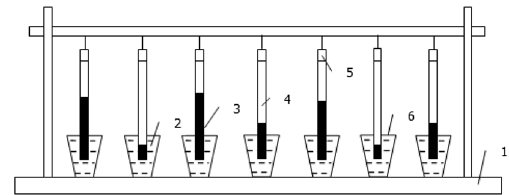
Fig. 1 Flowchart of self-priming speed method. 1 Bracket, 2 wetting solution, 3 wetting pulverized coal, 4 dry pulverized, coal, 5 glass, 6 beaker